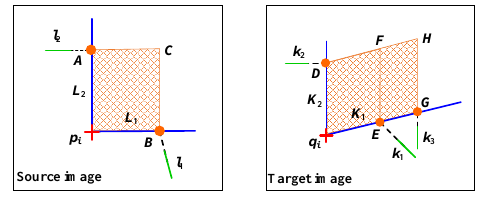
Figure 5. Comparison of NNDR and I-NNDR matching